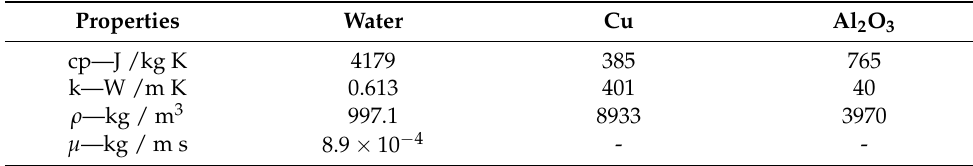
Table 1. Thermophysical properties of PF and NPs